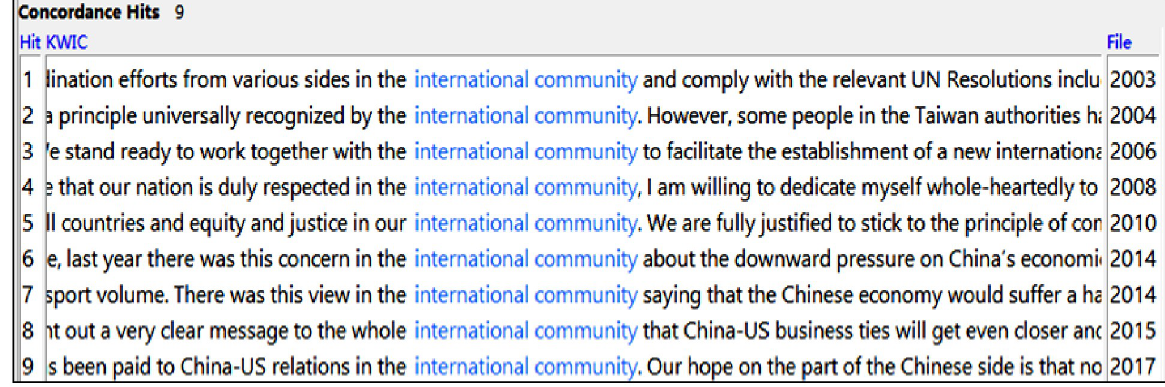
Fig 2. Screenshot of concordance lines featuring ‘international community’ (by